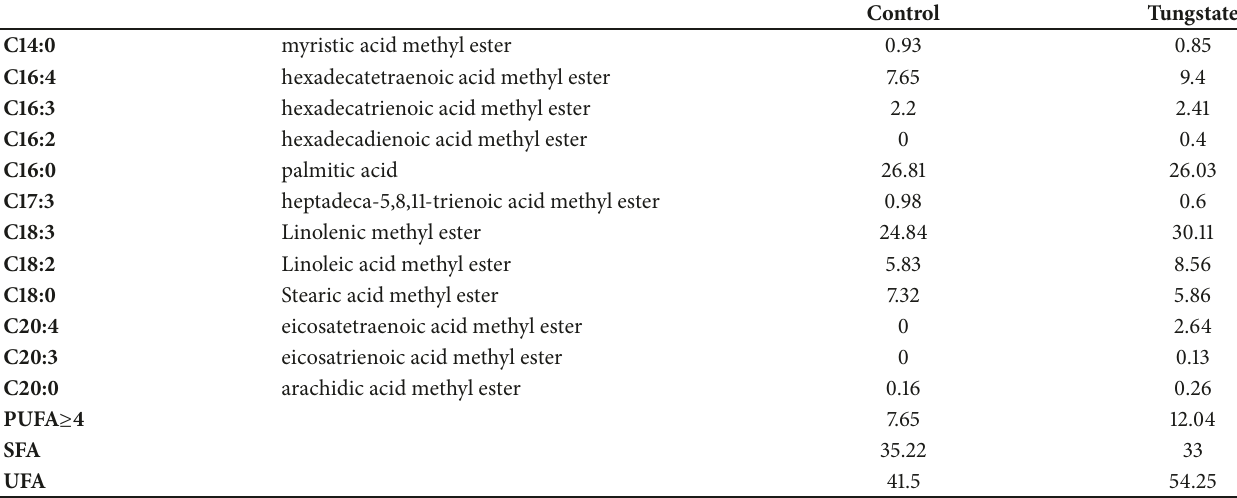
Figure 3: Effect of tungstate on total and neutral lipid accumulation in D. tertiolecta . (a) Lipid content (histogram) and lipid productivity per cycle (squares). (b) Neutral lipids droplets accumulation in D. tertiolecta stained with Nile red dye. (c) Neutral lipid analysis by spectrofluorimetry expressed as 𝜇 g of neutral lipids/millions of cells. All cultures were cultivated in Guillard F/2 medium. Tungstate (10mM) was added to the cultures at the beginning of culture one-stage treatment or at 7th day ‘two-stage treatment’. Data are mean ± standard deviation. Table 1: Fatty acid methyl ester (FAMEs) profile of D. tertiolecta analyzed by GC-MS at the 15th day. Sodium tungstate (10 mM) was added to the cultures at the beginning of culture one-stage treatment. PUFA: polyunsaturated fatty acids; SFA: saturated fatty acids; UFA: unsaturated fatty acids.